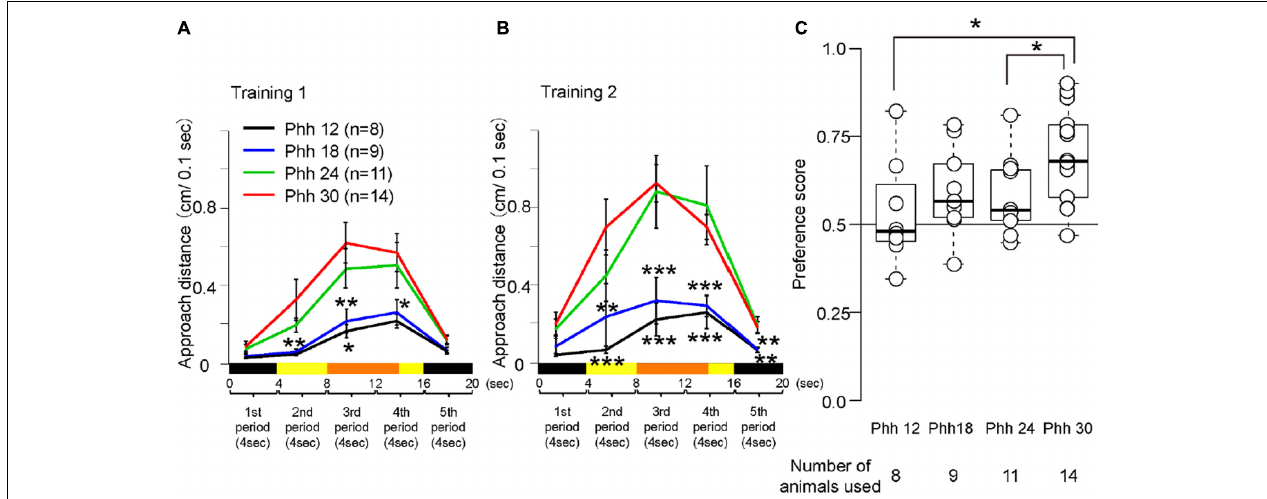
FIGURE 3 | Behavior of chicks at Phh 12, 18, 24, or 30 in the imprinting training and test. (A) Averaged approach distances in training 1 are shown. One trial of 20 s was divided into five periods (4 s each). The black line indicates the approach distances of chicks at Phh 12. The blue line indicates the approach distances of chicks at Phh 18. The green line indicates the approach distances of chicks at Phh 24. The red line indicates the approach distances of chicks at Phh 30. The approach distances of the chicks at Phh 24 were not significantly different from those of the chicks in any period at Phh 30. The approach distances of the chicks at Phh 18 from the second to fourth period were significantly less than those of the chicks at Phh 30. The approach distances of the chicks at Phh 12 in the second and third periods were significantly less than those of the chicks at Phh 30. (B) Averaged approach distances in training 2 are shown. The approach distances of the chicks at Phh 24 were not significantly different from those of the chicks in any period at Phh 30. The approach distances of the chicks at Phh 12 and 18 from the second to fifth period were significantly less than those of the chicks at Phh 30. (C) Preference scores in the test are shown. Preference scores of chicks at Phh 12 and 24 were significantly lower than those of chicks at Phh 30. The asterisks (*) indicate significance (* p < 0.05; ** p < 0.01; *** p < 0.005).